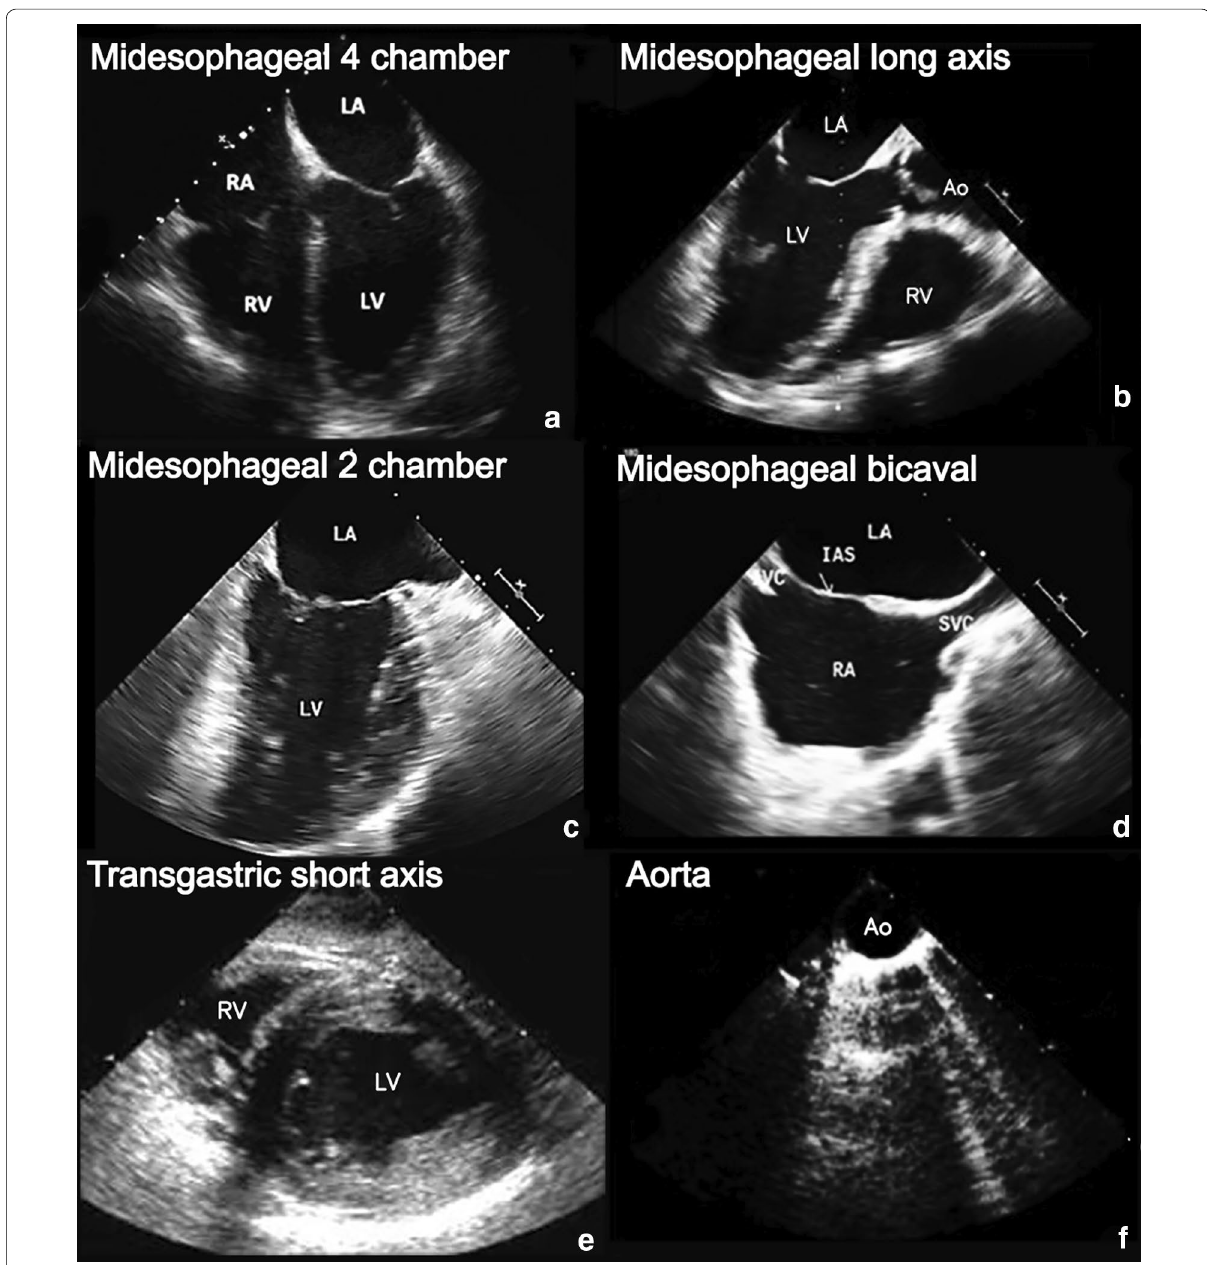
Fig. 1 a Mid-esophageal four-chamber view (ME4CH)—useful for evaluation of right and left ventricle function and size, mitral and tricuspid valve alterations, pericardial effusion and, during a pulse check, for the assessment of the presence of a perfusing rhythm. b Mid-esophageal long-axis view (MELAX)—helpful for the evaluation of the left ventricular systolic function and, during CPR, for the evaluation of compression adequacy and location. c Mid-esophageal two-chamber view (ME2CH)—valuable for the evaluation of the left ventricular systolic function and the regional motion of the anterior and inferior wall. d Mid-esophageal bicaval view (MEbicaval)—allows the evaluation of superior vena cava thrombus, catheters or venous cannula position (as for ECLS) and respiratory dimensions variations that can be related to volume status and fluid responsiveness. e Transgastric short-axis view (TGSAX)—provides information about pericardial effusion, left ventricle systolic function and regional wall motion abnormalities. f Aorta view (AOview)—useful for guiding vessel cannulation for ECLS and for the identification of aortic dissection/ aneurysm involving the aortic arch and the descending thoracic aorta. Ao aorta, IAS interatrial septum, IVC inferior vena cava, LA left atrium, LV left ventricle, RA right atrium, RV right ventricle, SVC superior vena